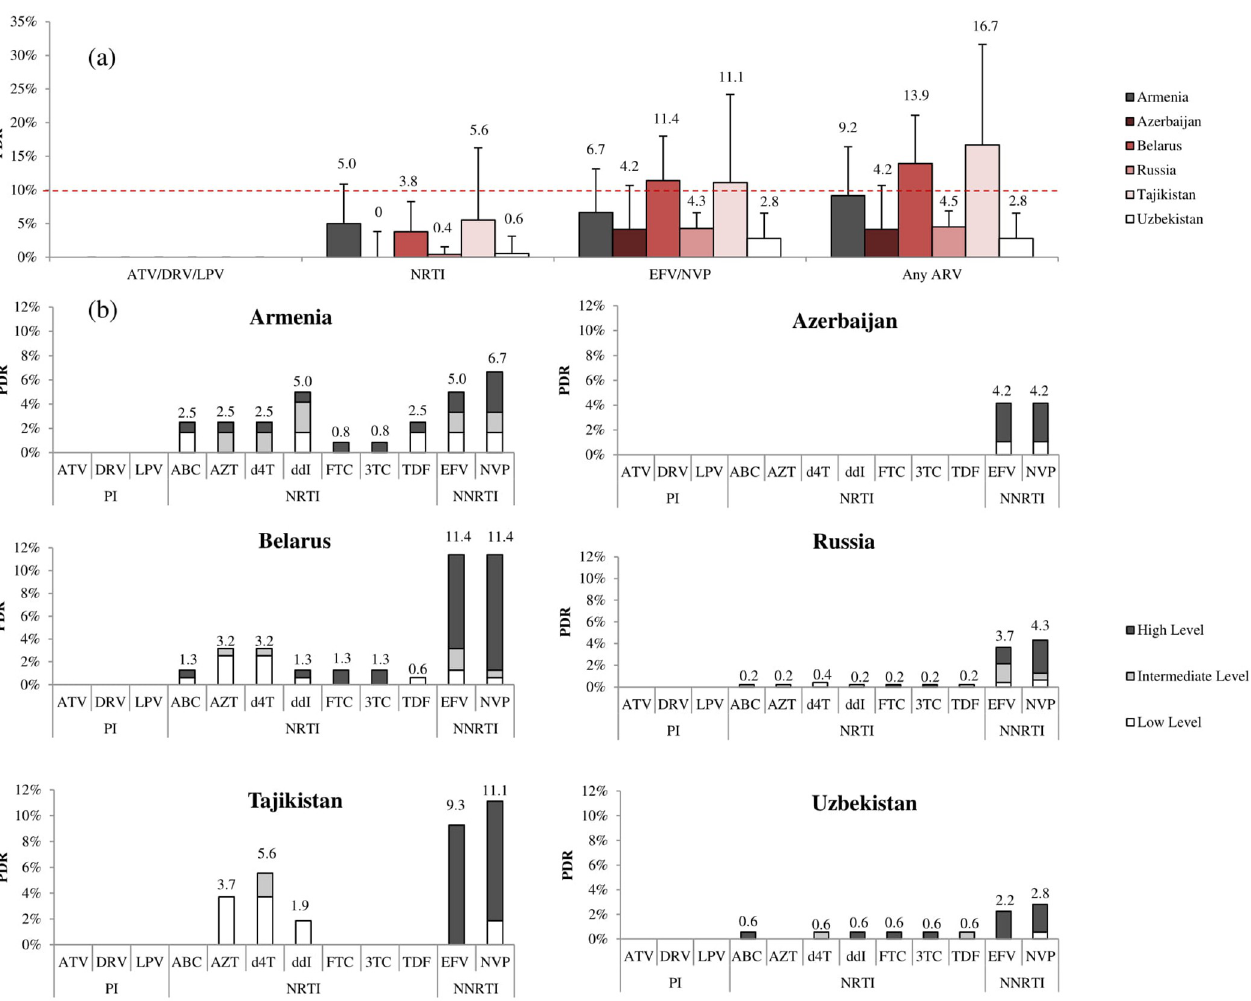
Fig 1. The prevalence of PDR in the six countries according to (a) drug class and (b) antiretroviral drug. The lines represent the 95% CI. ATV, atazanavir; DRV, darunavir; LPV, lopinavir; ABC, abacavir; AZT, zidovudine; d4T, stavudine; ddI, didanosine; FTC, emtricitabine; 3TC, lamivudine; TDF, tenofovir disoproxil fumarate; EFV, efavirenz; NVP, nevirapine. The WHO recommended 10% threshold is indicated by the red dotted line.